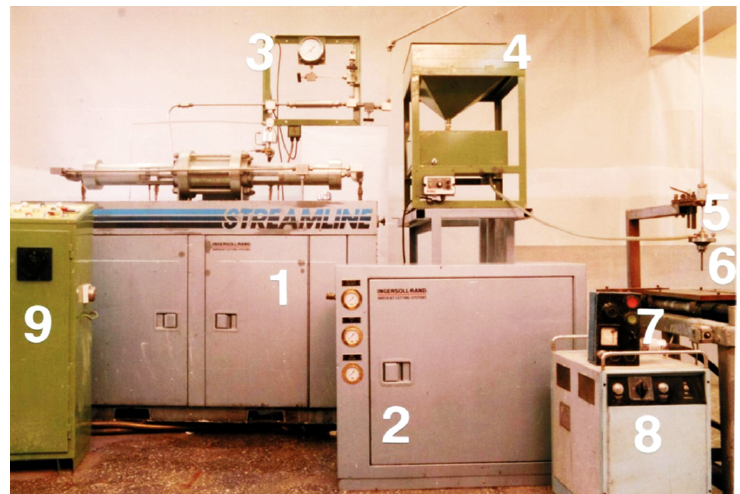
Figure 4. General view of the high-pressure hydroabrasive cutting station: 1—high-pressure pump, 2—pre-pump, 3—measuring panel, 4—abrasive feeder, 5—working head, 6—hydroblasting nozzle, 7—working table, 8—table speed controller, 9—control